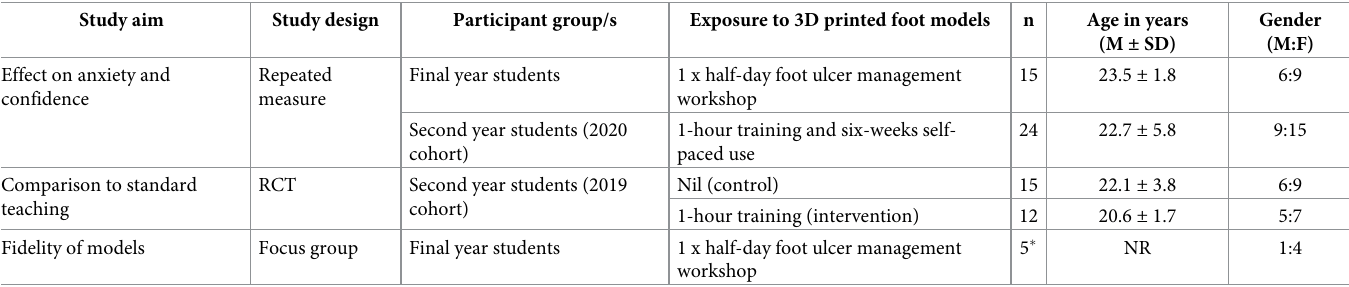
Table 1. Participant characteristics for the multiple method